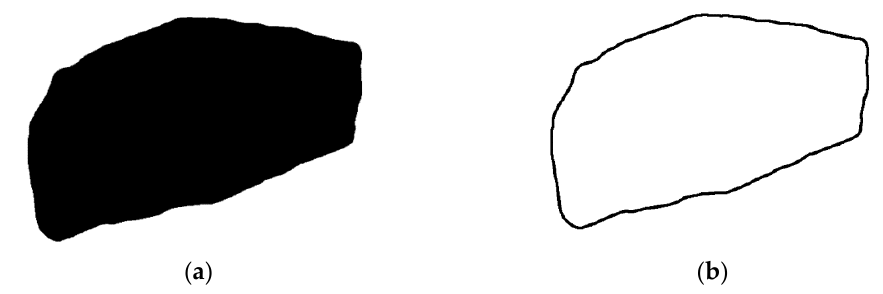
Figure 1. Binary images of aggregate particles: ( a ) shape; ( b ) shape contour.